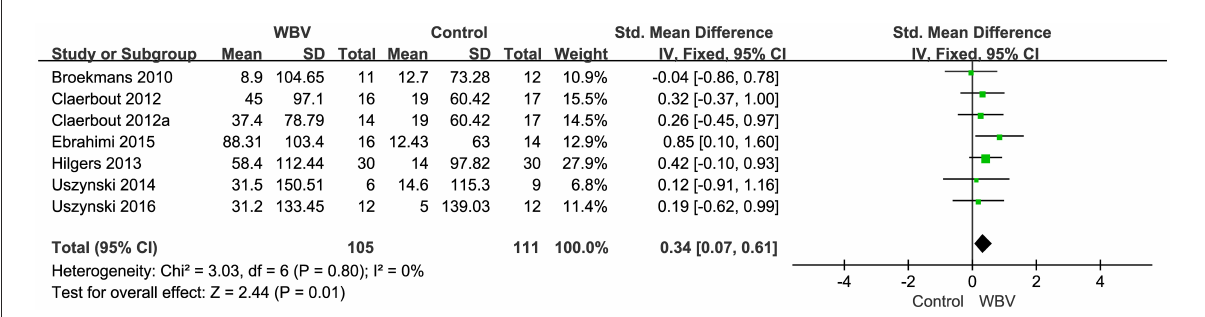
FIGURE7 Forest plot showing the effects of WBV on walking endurance.